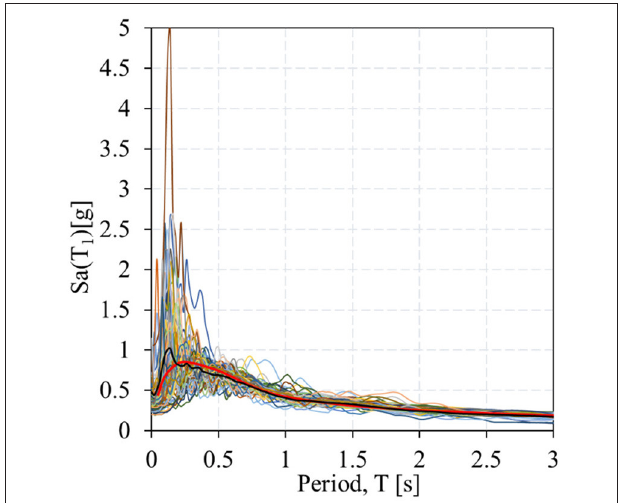
FIGURE 5 | Example of selected ground motion records for 3S_D&MD_NI (T 1 =